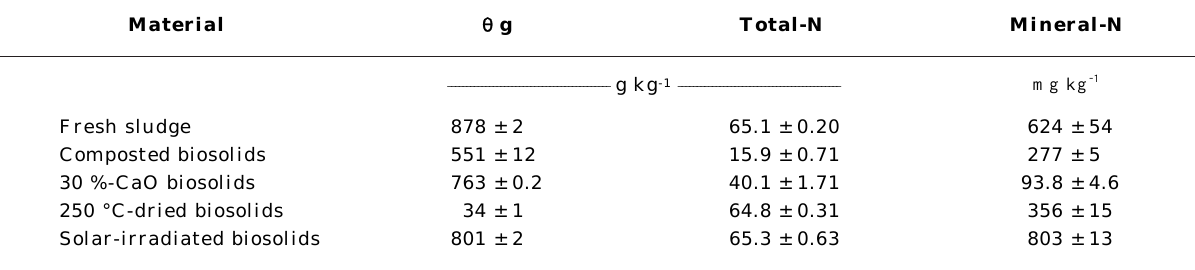
Table 1. Moisture ( θθθθθ g), total-N, and mineral-N of biosolids (means ± standard deviations, n = 3)